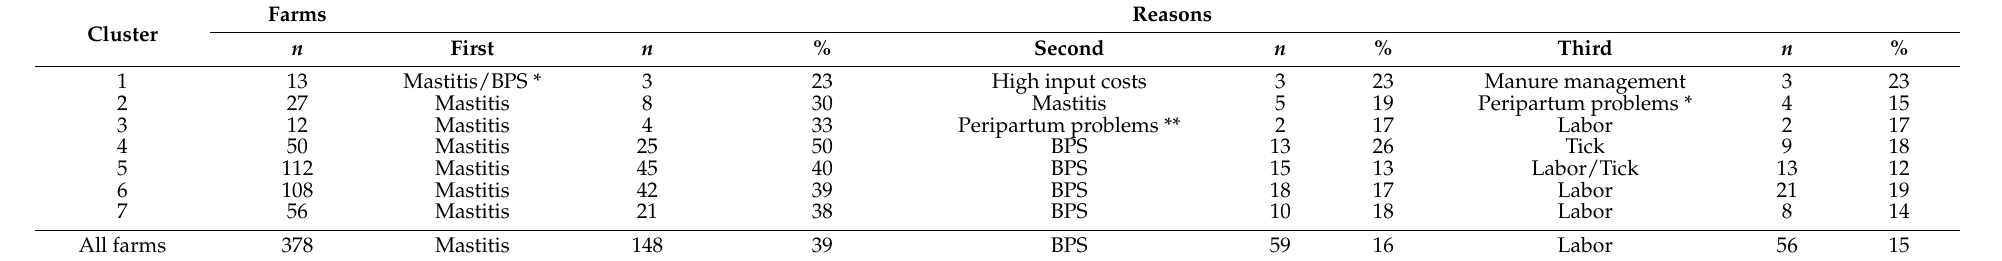
Table 10. Top three problems faced by